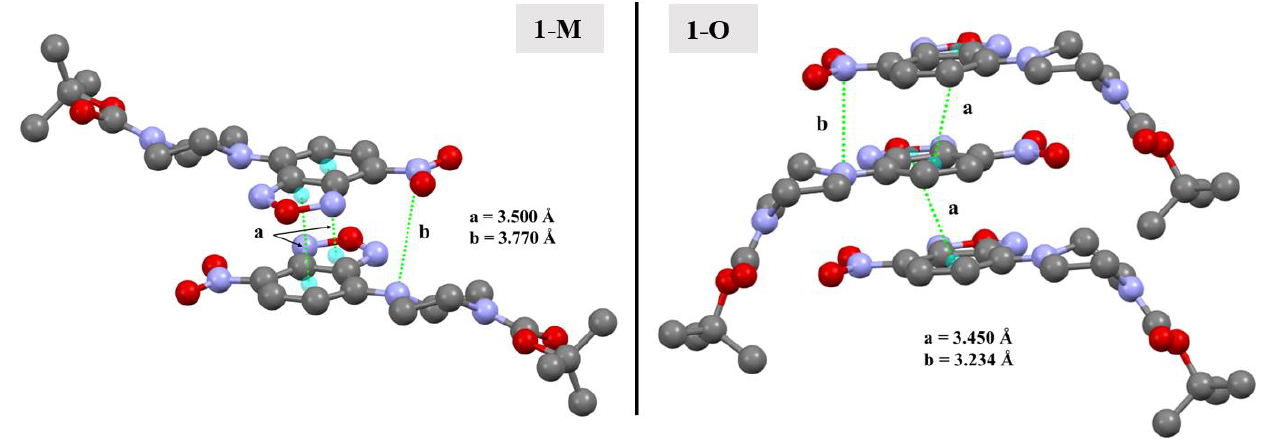
Figure 14. Depictions of the π - π interactions in 1-M and 1-O ( a ) and the N···N NO2 π -hole interactions ( b ). Hydrogens omitted for clarity.